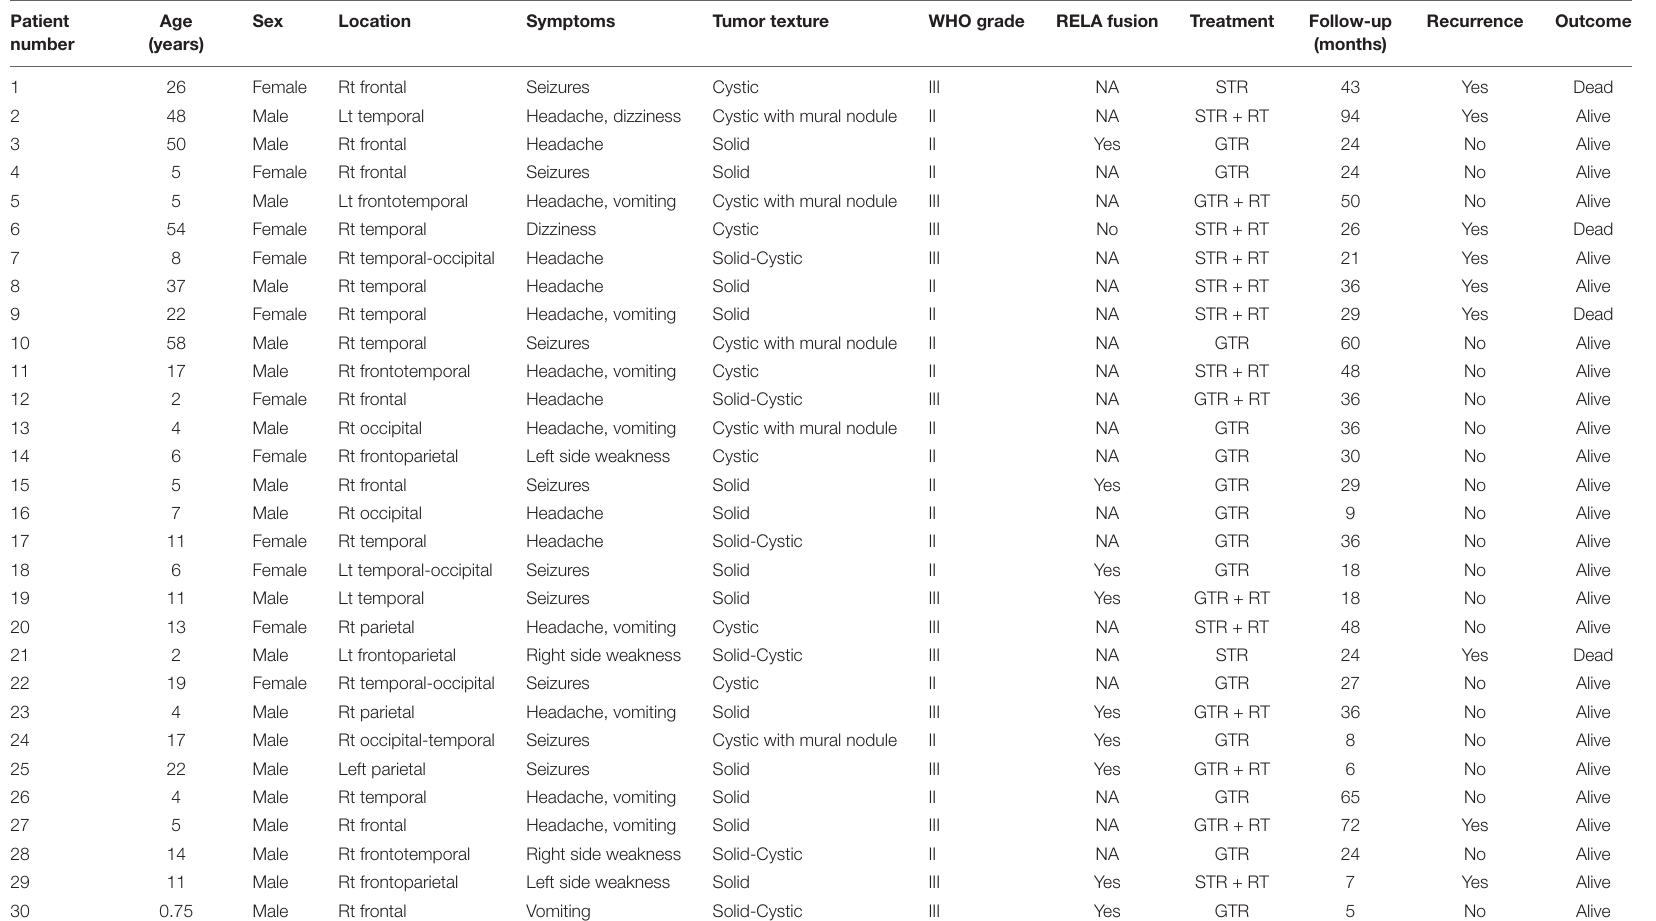
TABLE 1 | Overview of patient data of our institutional series.